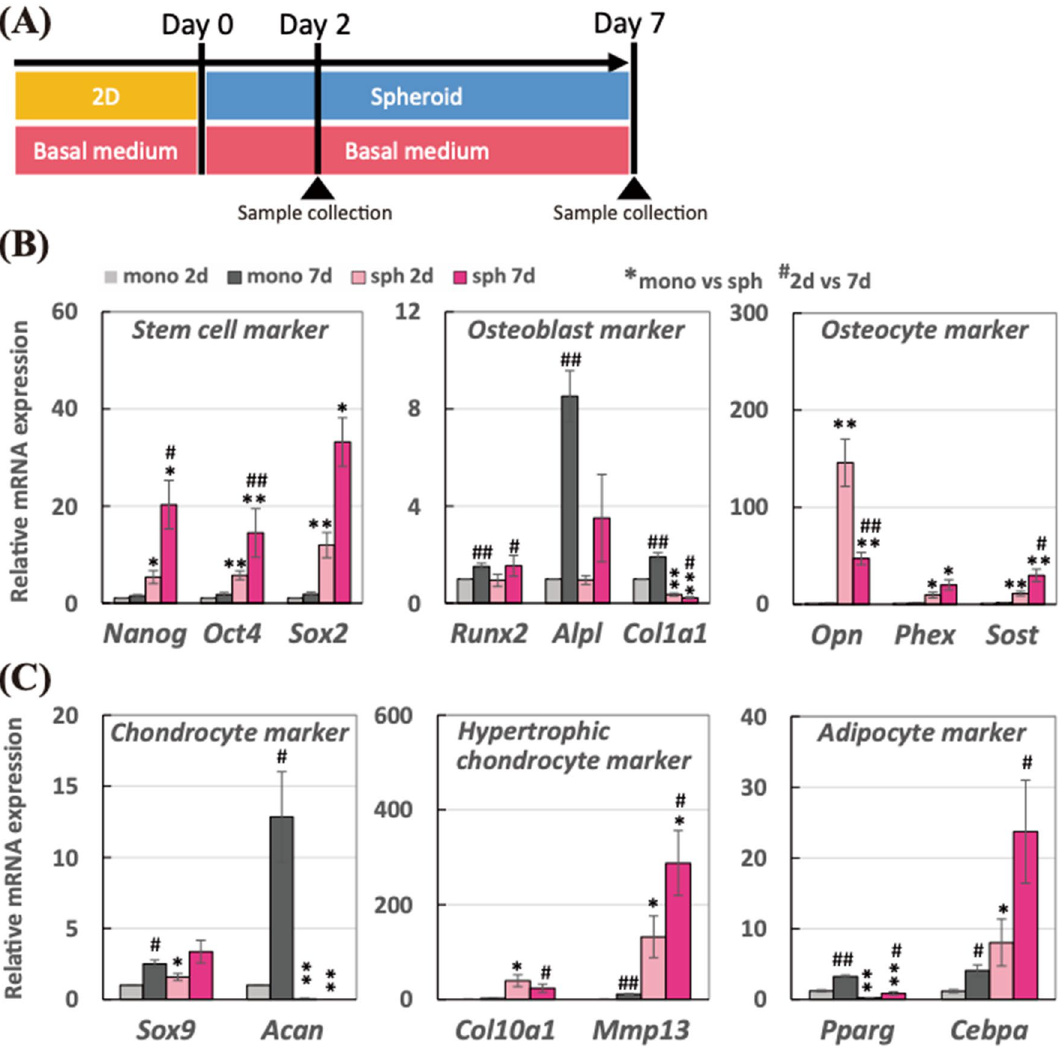
Figure 3. ( A ) Schematic of the experimental time line for spheroids incubated in the basal medium in the absence of osteogenesis supplements for 7 days. Relative mRNA expressions of ( B ) stem cell markers ( Nanog , Oct4 , and Sox2 ), osteoblast markers ( Runx2 , Alpl , and Col1a1 ), osteocyte markers ( Opn , Phex , and Sost ), ( C ) chondrocyte markers ( Sox9 and Acan ), hypertrophic chondrocyte marker ( Col10a1 and Mmp13 ), and adipocyte markers ( Pparg and Cebpa ) were measured by real-time PCR. All the mRNA expressions were normalized to Gapdh expressions while the results were expressed as relative amounts against the expression of monolayer sample ( n = 10). The bars represent the mean ± standard error. P -value was calculated from Student’s t -test (mono vs sph: * p < 0.05, ** p < 0.005; 2-day vs 7-day: # p < 0.05, ## p <